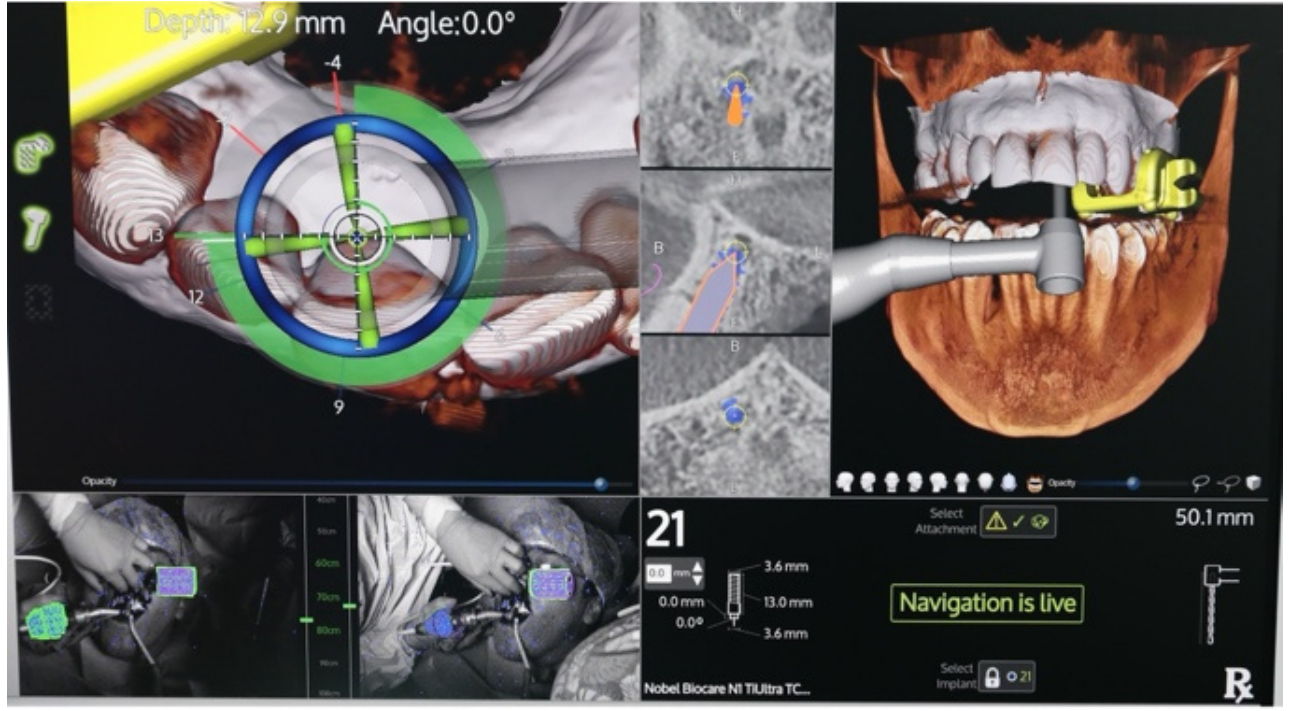
Figure 3. Implant placement with navigation system.